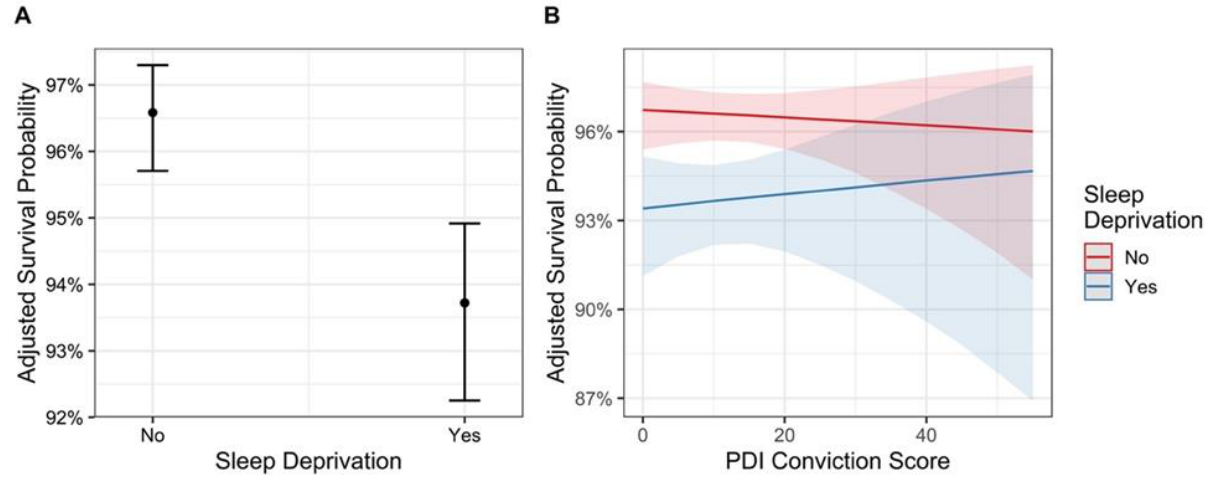
Figure 2. ( A ) Conditional effects of sleep condition (sleep deprivation no/yes) on adjusted survival probability and ( B ) interaction effect of sleep condition (sleep deprivation no (“normal sleep” group) in red and sleep deprivation yes (“sleep deprived” group) in blue) by PDI-21 conviction score. Error bars and bands represent 95% confidence intervals.